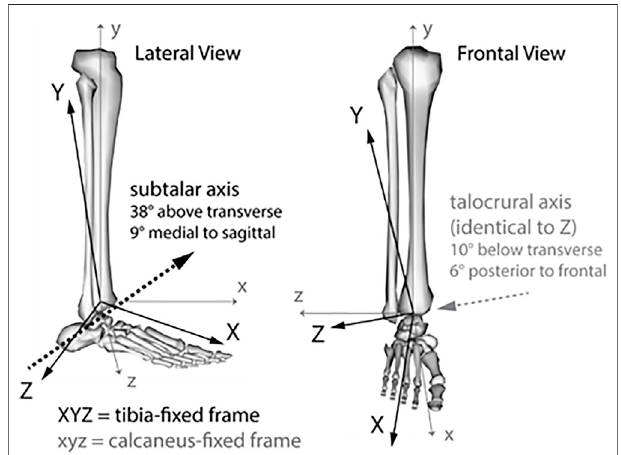
FIGURE 3 | Orientation of internal anatomic axes for the subtalar and talocrural joints, as de fi ned in the generic, baseline musculoskeletal model (Inman, 1976; Delp et al., 1990).